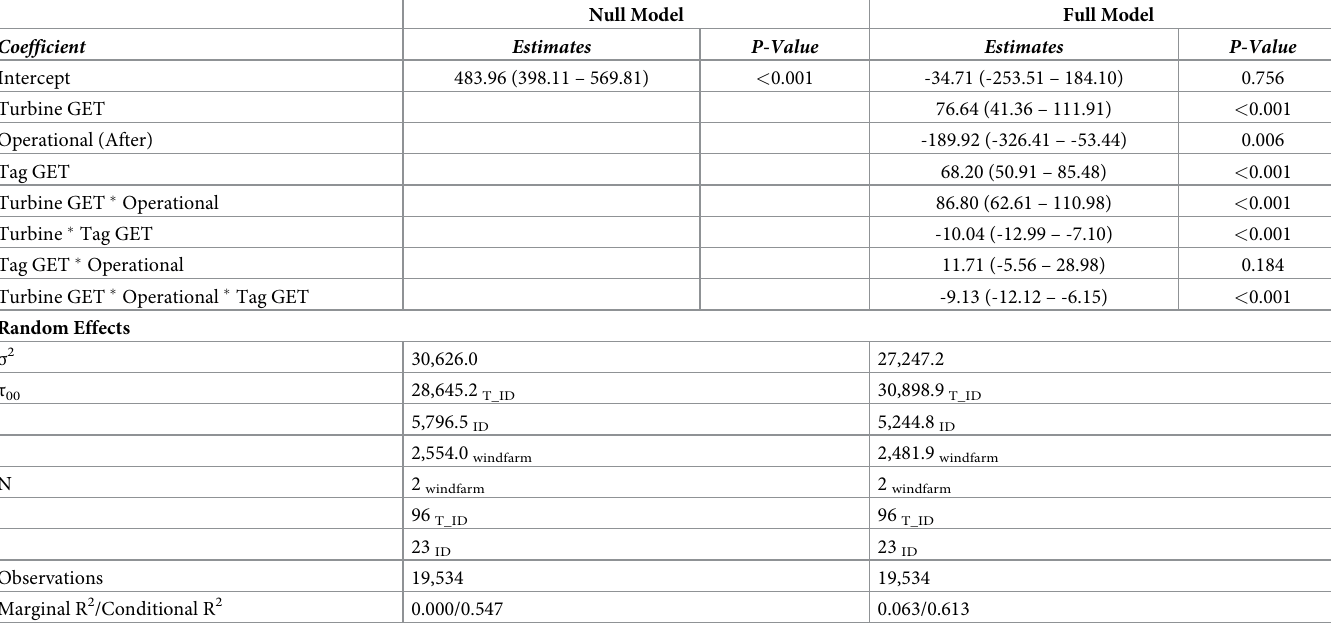
Table 2. Summary statistics for the best GLMM (Model 11: Table 1) examining 3-D distance of eagle tag records to the vicinity of a turbine location in before-and- after-operation analyses: Turbine GET = GET score at the turbine location, Postop = a binary value around the date when a turbine became operational, Tag GET = GET score at the tag location, � indicates